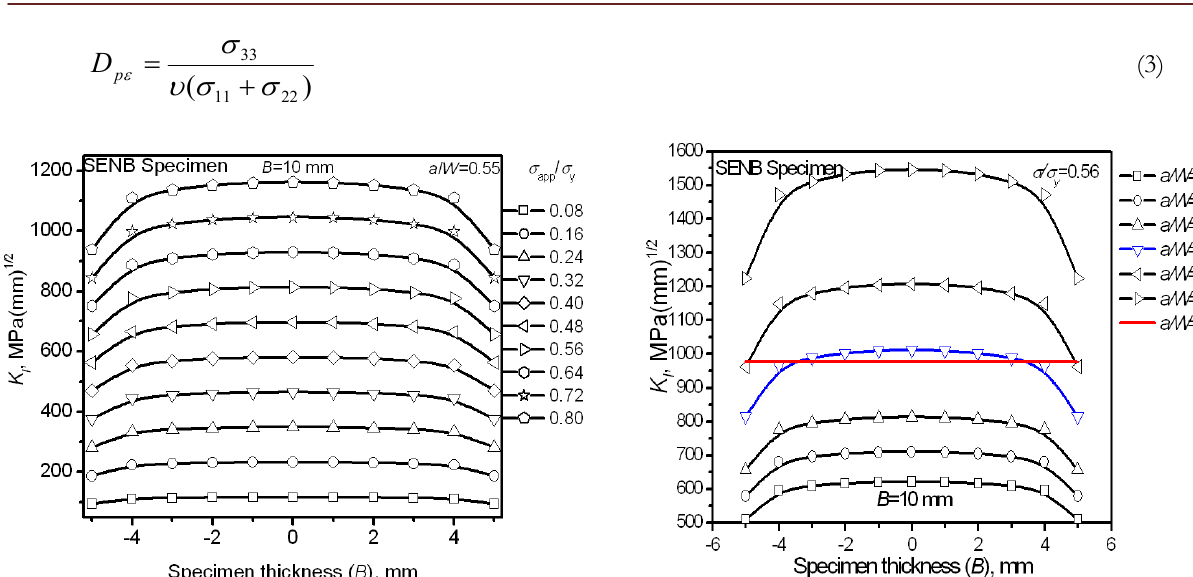
along the crack-front for B =10 mm and I